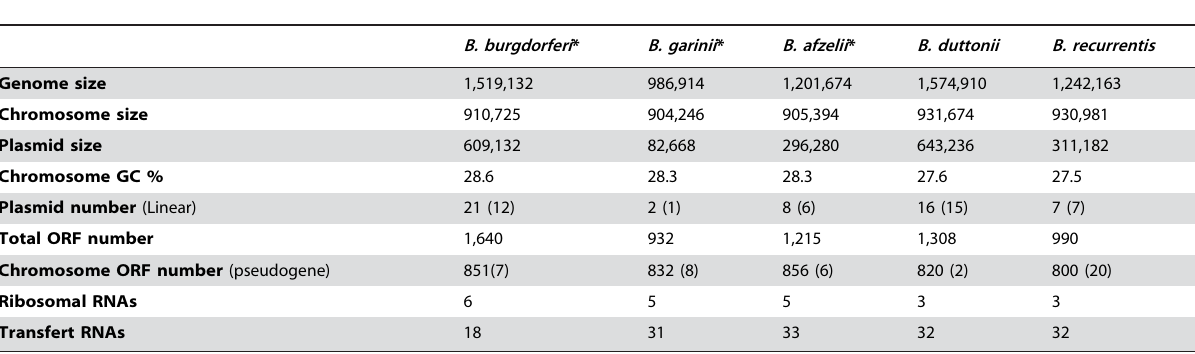
Table 1. General features of the Borrelia genomes. Size is given in base pair